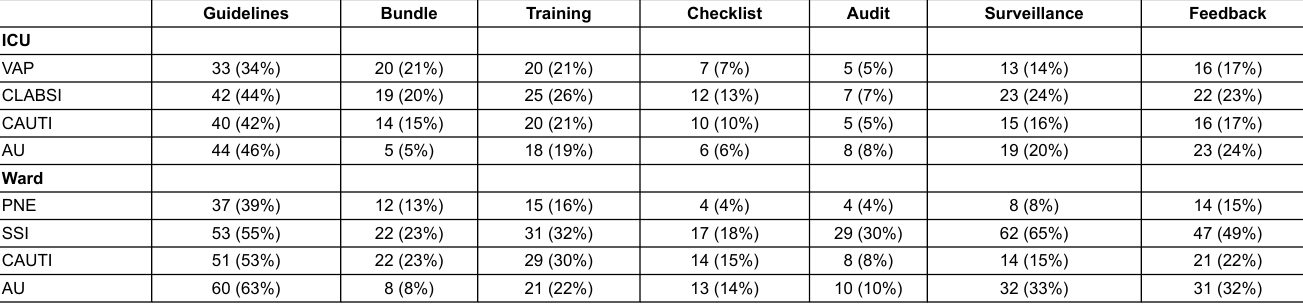
Table S3: Multimodal strategies at the ICU or ward level in participating hospitals.